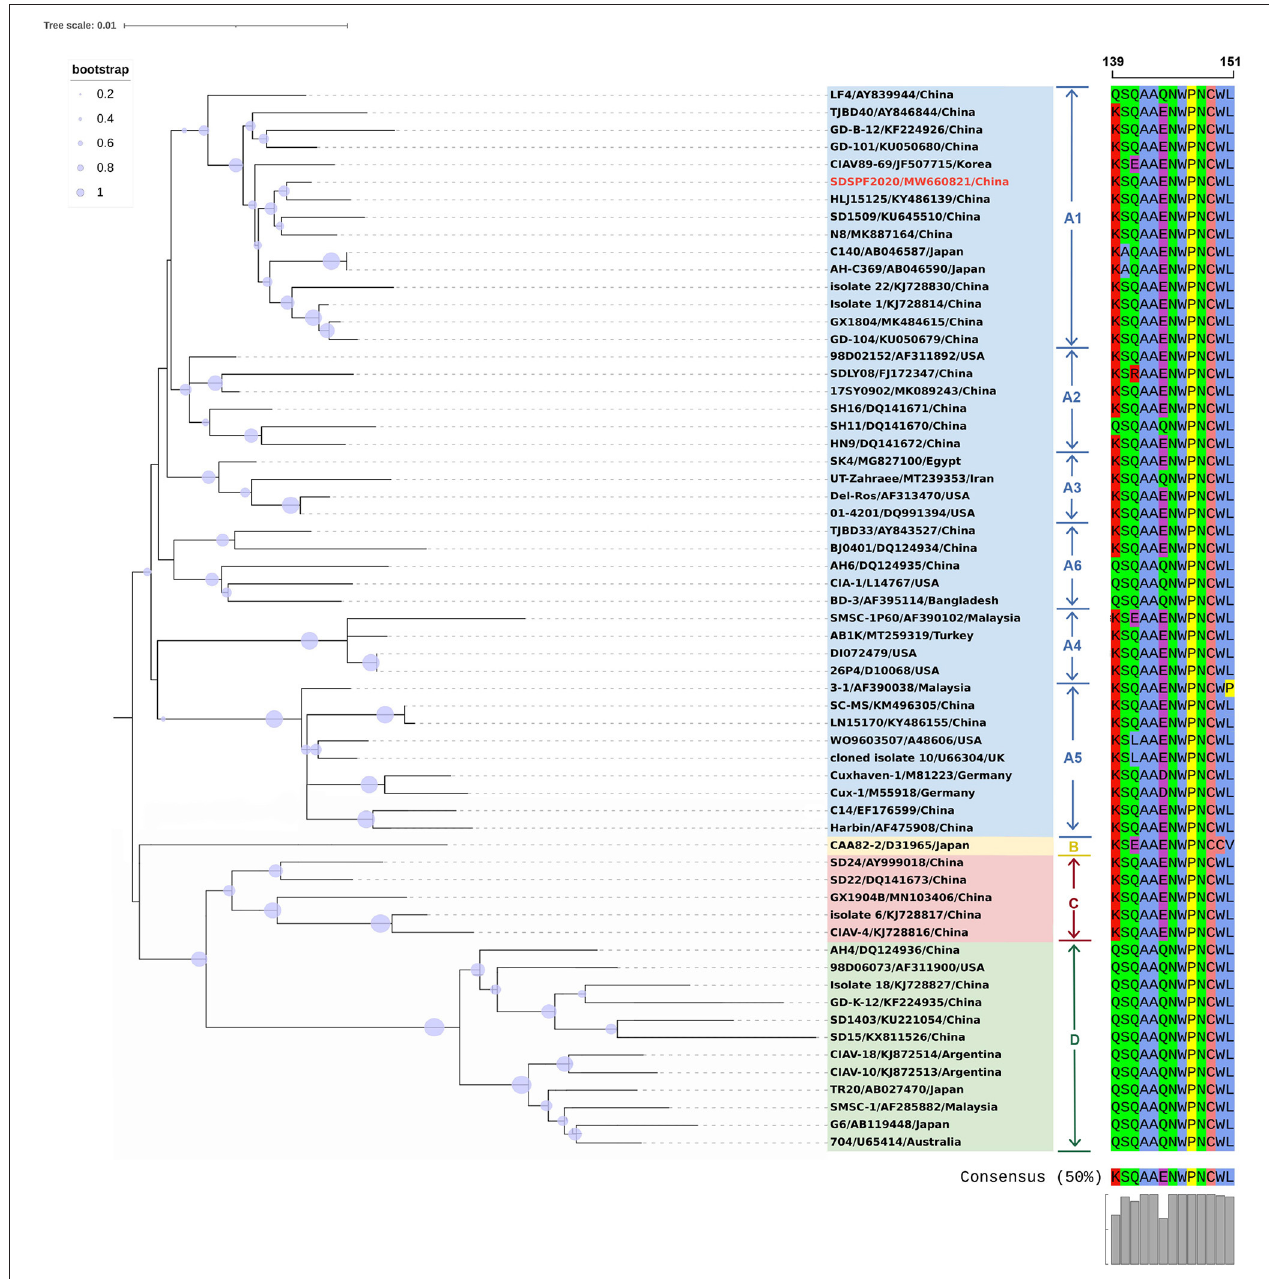
FIGURE 1 | Phylogenetic relationships of SDSPF2020 and other available reference CIAVs in GenBank based on complete genome nucleotide sequences. The phylogenetic trees were generated by neighbor-joining method (1,000 bootstraps) using MEGA X software. The red label represents the strain of the CIAV-SDSPF2020, and a multiple sequence alignment of VP1 protein hypervariable regions (amino acid 139–151) is visualized directly next to the tree. The viruses were clearly divided into 4 genogroups from A to D, and group A included six